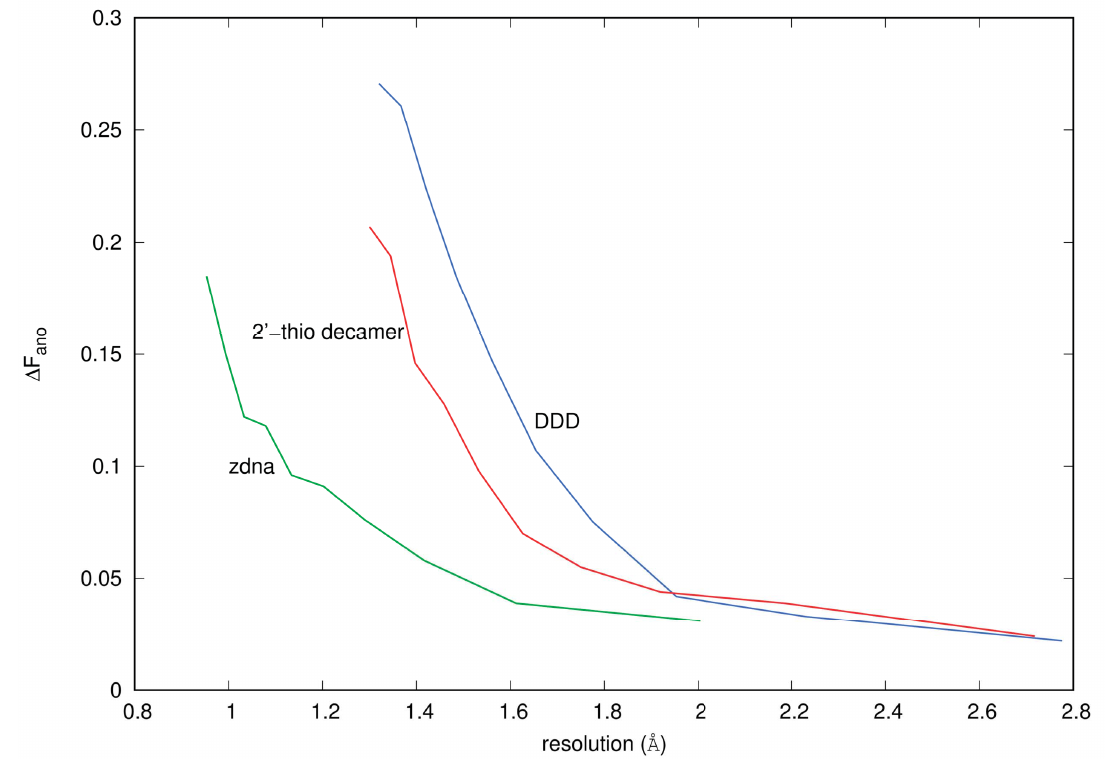
Figure 9. The signal to noise ratio evaluated using ∆ F ano versus resolution plotted for the three data sets, zdna, DDD, and 2’-thio decamer. The data were calculted by resolution bin using 10 bins each for